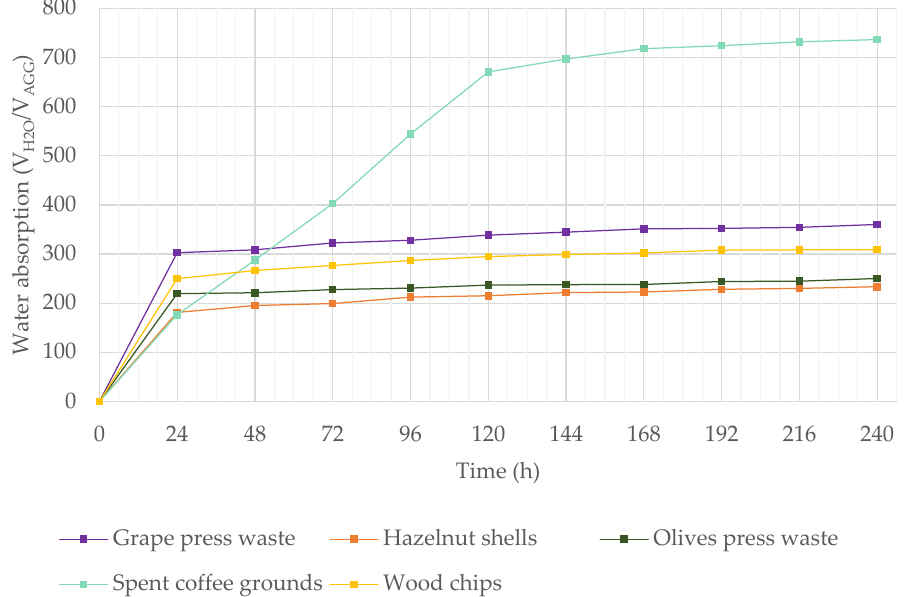
Figure 7. Variation of water absorption during time considering the ratio of the volume of absorbed water and the volume of the material.